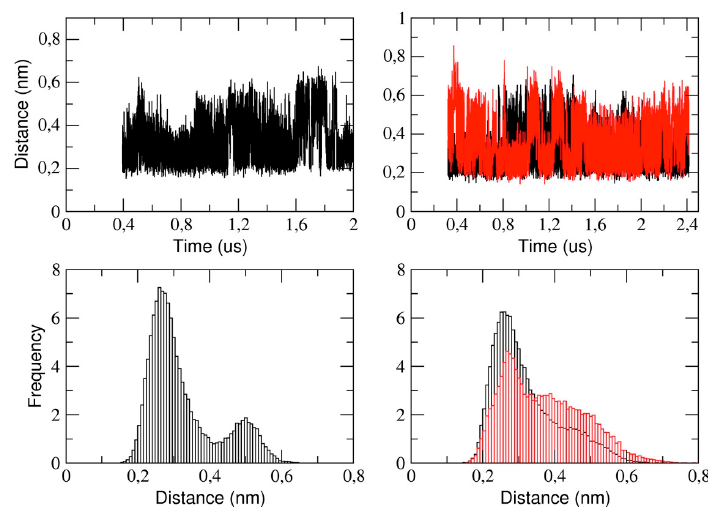
Figure 7. The distance computed between the catalytic dyad residues His-41 and Cys-145 during MD simulations for the monomeric (upper left graph) and for the dimeric (upper right graph) form of 3CLpro. In the lower graph, the frequency of the distances is represented for the monomer on the left and for the dimer on the right. For the dimer, the two chains are highlighted in different colors: chain A in black line and chain B in red line in both graphs.